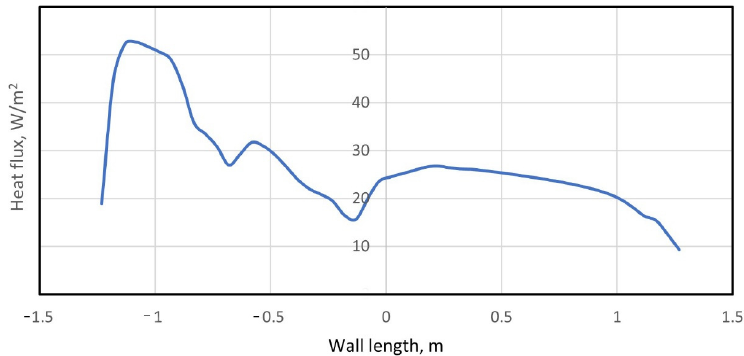
Figure 13. Heat flux q on the right wall.